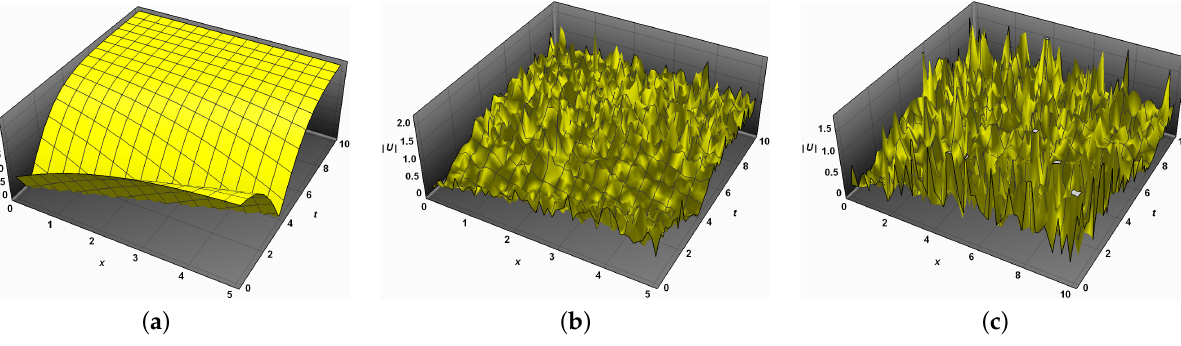
Figure 5. The solution (36) for different values of the noise σ and α = 1, y = 0.5 and ( x , t ) ∈ [ 0,10 ] × [ 0,10 ] . ( a ) σ = 0.0; ( b ) σ = 0.2; ( c ) σ = 0.5.